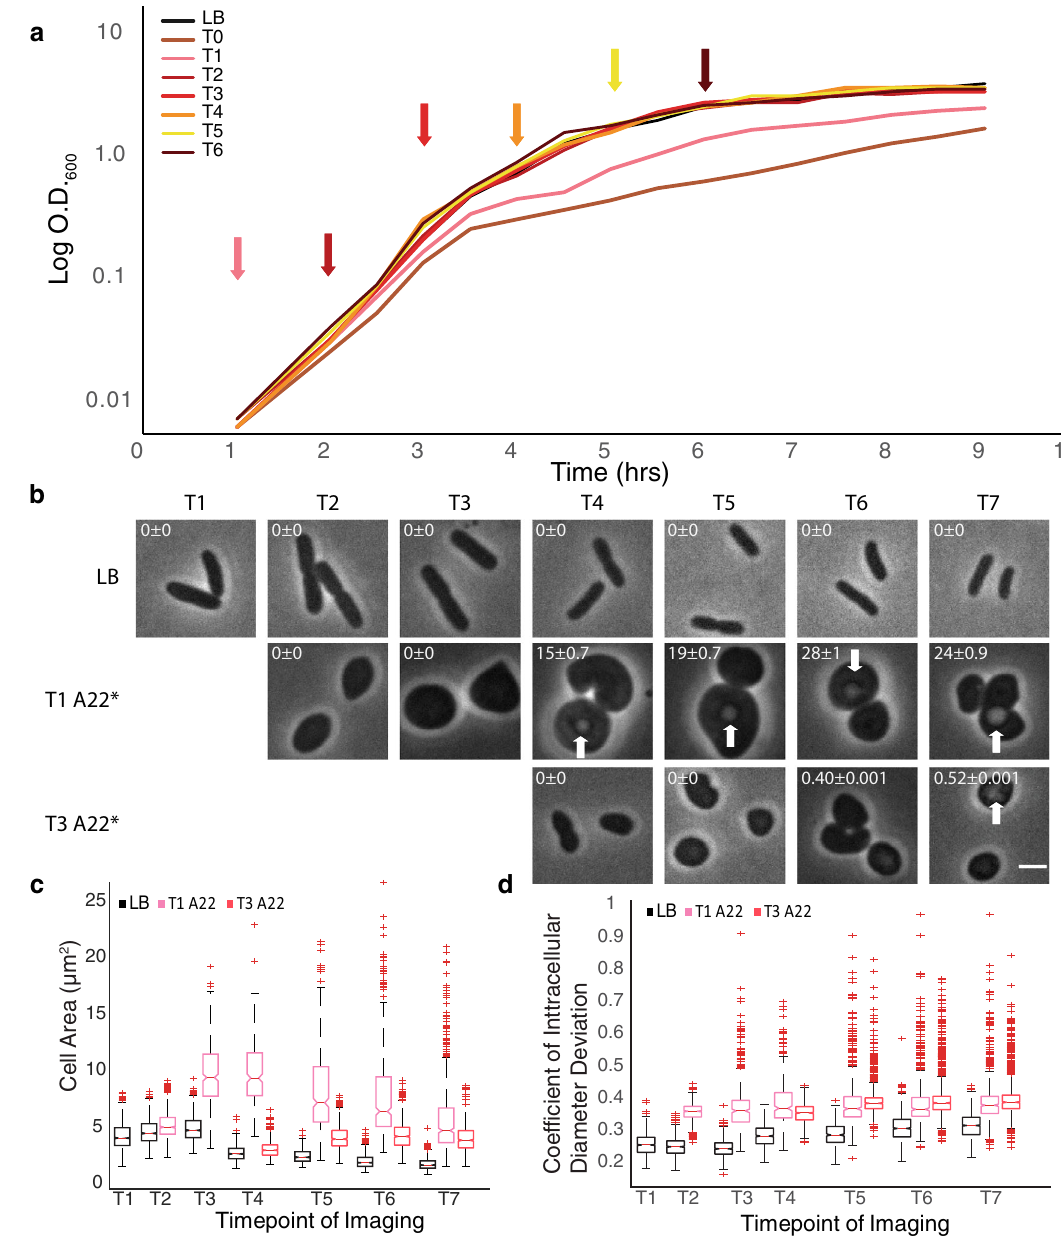
Fig. 1 Timing of A22 addition is important for growth rate changes. a Representative growth curve of WT cells at 37 °C with A22 (10 µ g/ml) added every hour from 0 to 6 h as indicated by corresponding arrows. b Representative phase-contrast images of WT cells grown at 37 °C in LB, LB with A22 (10 μ g/ ml) added at 1 h of growth, and LB with A22 added at 3 h at growth. Cells were imaged every hour for 7 h. White arrow indicates cell vesicles forming in advance of lysis and numbers in the upper left represent the percentage of cells displaying vesicles and the Poisson error to one standard deviation. The scale bar is equal to 2 µ m. c , d Quanti fi cation of cells imaged in b . Red pluses are outliers, the red line is the median, the bottom and top edges of the box represent 25th and 75th percentiles, respectively, and notches are 95% CI. Data were pooled from three independent experiments. c Cell area from cells imaged in b . d Coef fi cient of intracellular diameter deviation from cells imaged in b . c , d Number of cells can be found in table